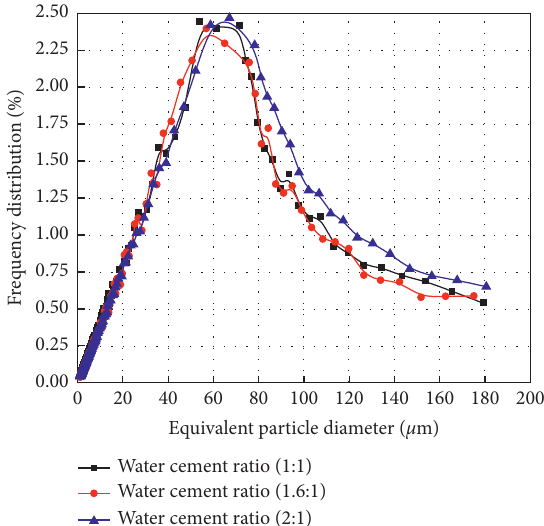
Figure 5: Gradation curve of flocculated